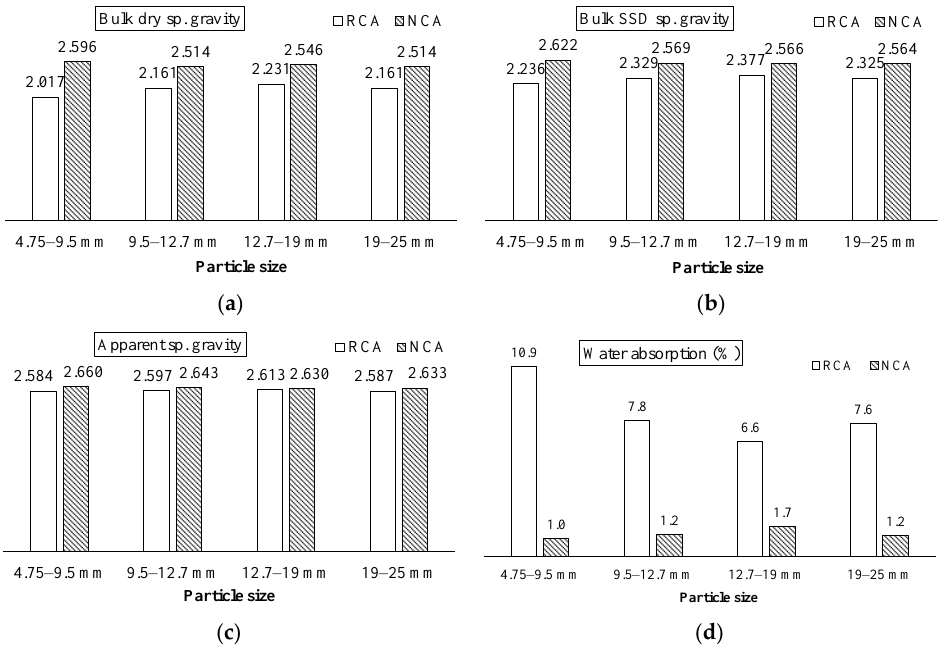
Figure 1. Physical characteristics of various size fractions of RCA and NCA: ( a ) Bulk dry specific gravity; ( b ) Bulk SSD specific gravity; ( c ) Apparent specific gravity; and ( d ) Water absorption.